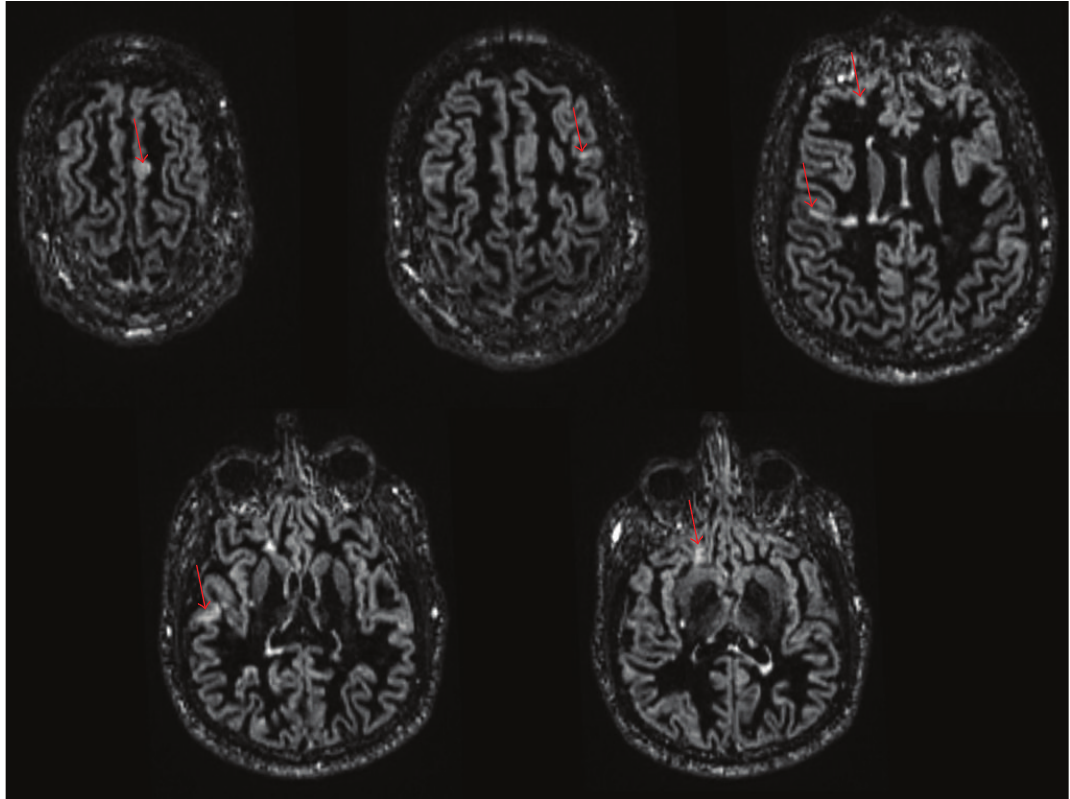
Figure2:CorticallesionsinMSonDoubleInversionRecovery.41-year-oldfemalepatientwithRRMS.MultipleaxialDIRimagesdemonstrate multiple small cortical and leukocortical lesions scattered in the supratentorial brain (red